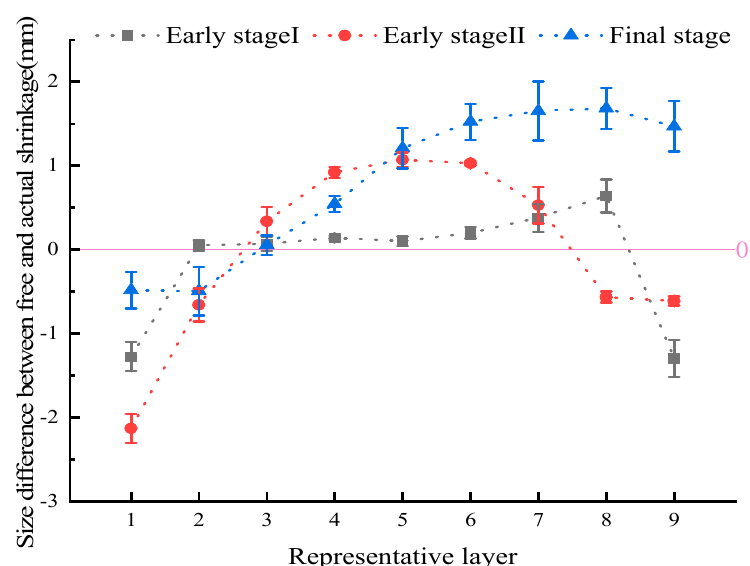
Figure 4. Comparison of the free and actual drying shrinkage of each layer in the thickness of Mon- golian Scotch pine at each stage of conventional drying.